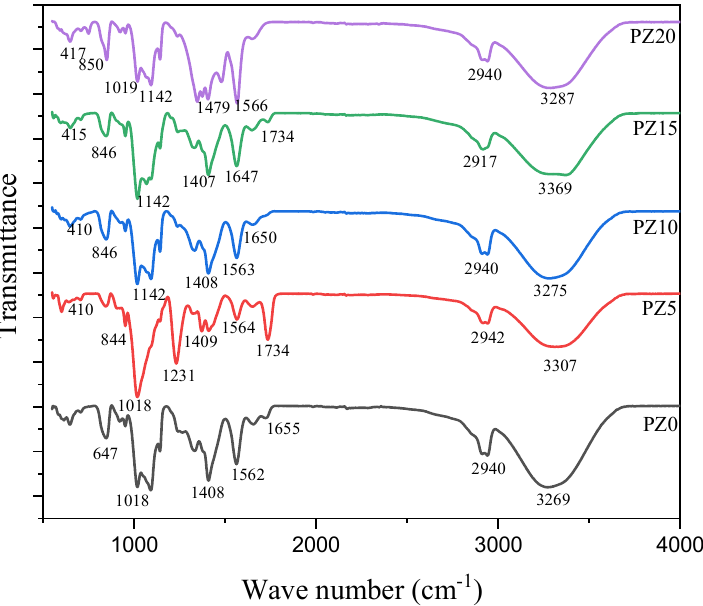
Figure 3. FTIR spectra of pure PVA–CA–K 2 CO 3 composite SPEs (PZ0) and PVA–CA–K 2 CO 3 composite SPEs with varying concentrations of ZnO-NPs from 5 to 20 wt % (PZ5 to PZ20).